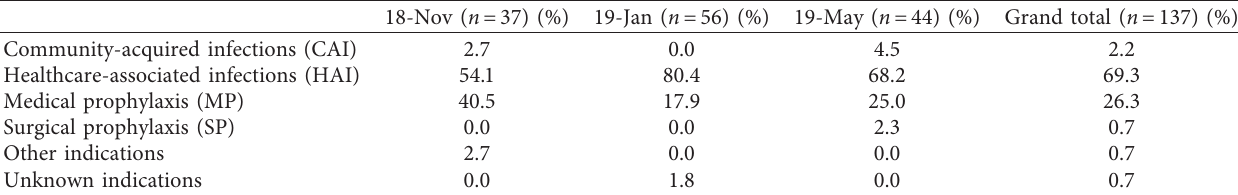
Figure 2: AWaRe classification for systemic use antibiotics (J01) during three survey periods in November 2018, January 2019, and May 2019 at the Maruki Memorial Welfare and Medical Center, Japan. Table 3: Indications for antimicrobial prescribing (percentage of antimicrobial prescriptions) at the Maruki Memorial Welfare and Medical Center, Japan, in November 2018, January 2019, and May